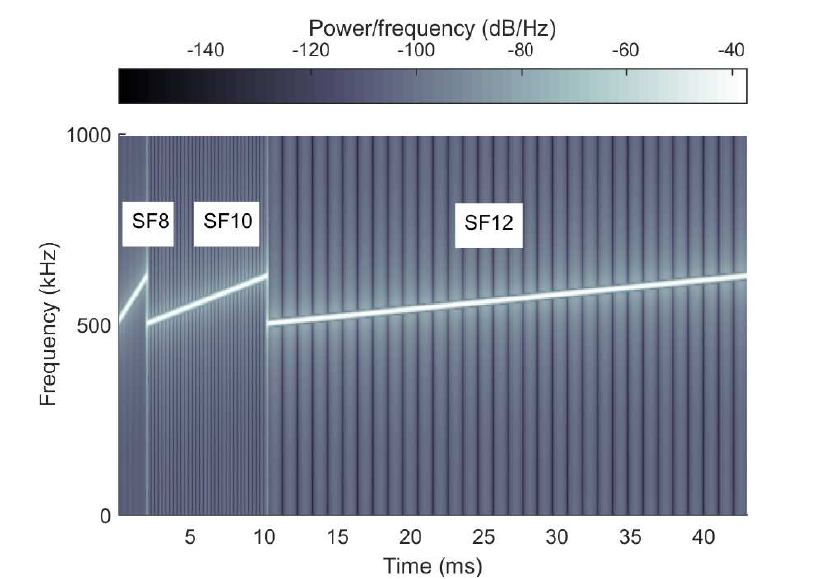
Figure 1. The spectrogram of the symbols generated by SF 8, SF 10 and SF